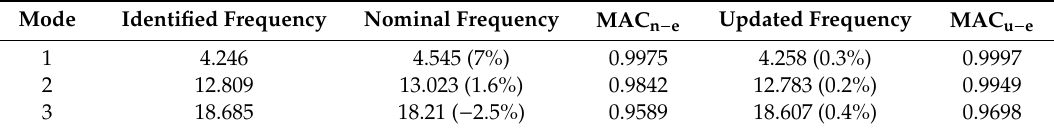
Table 4. Comparison of modal parameters of nominal and updated models with those of experimental